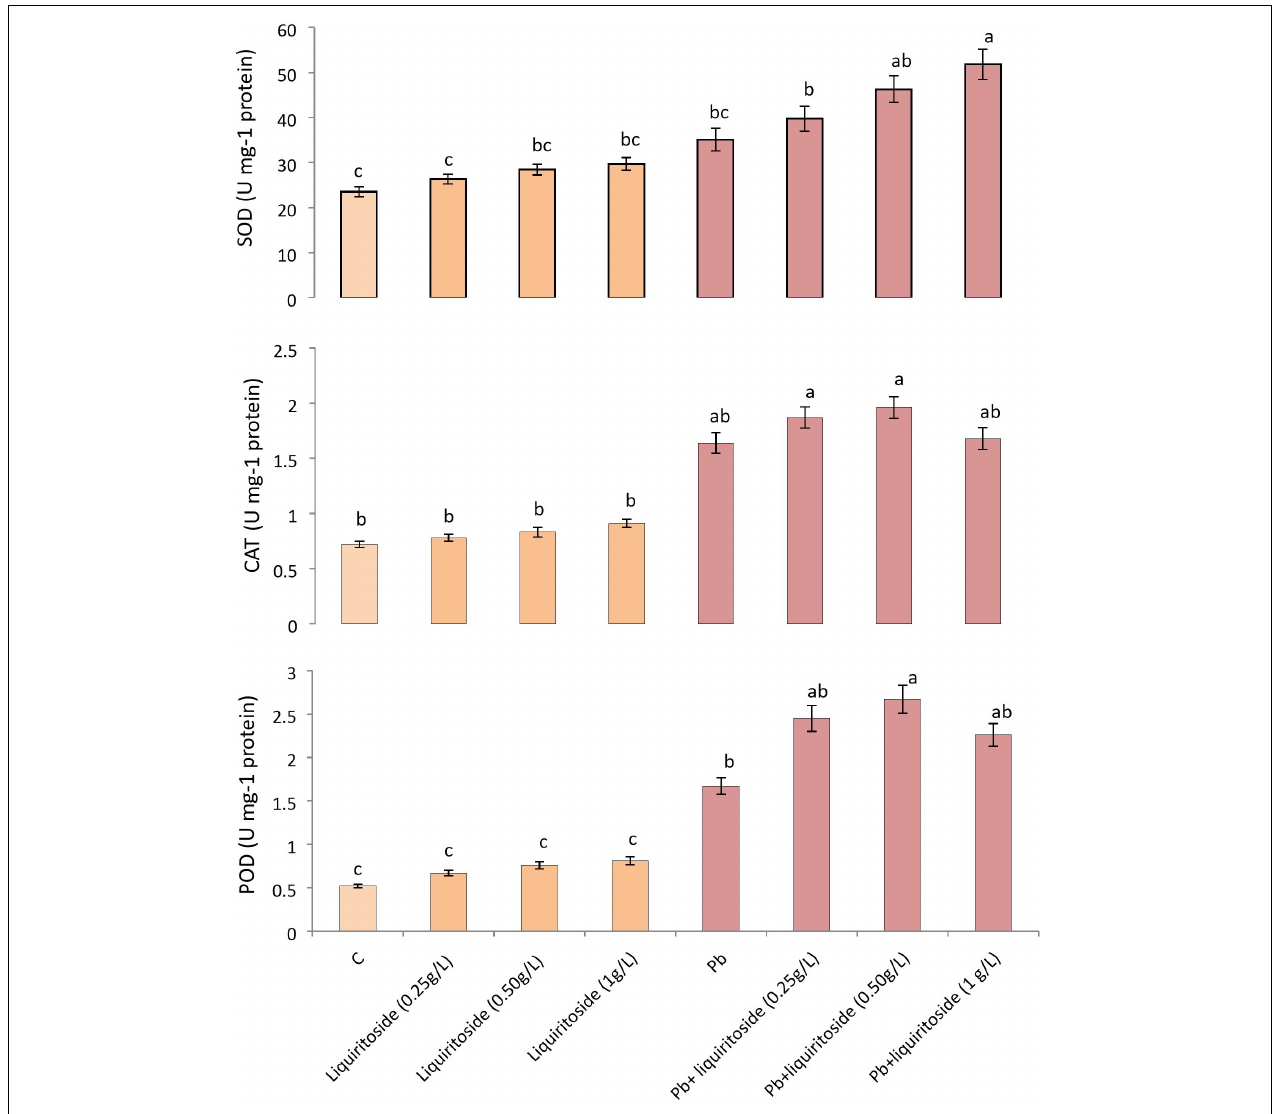
FIGURE 2 | Effect of liquiritoside on the magnitudes of antioxidant enzymes such as SOD, POD, and CAT in Chinese flowering cabbage plants under lead stress. Mean values of two independent experiments are presented. Vertical bars show standard error between different replicates of the same treatment. Data marked by different letters are significantly different at p < 0.05. Pb, lead; C,